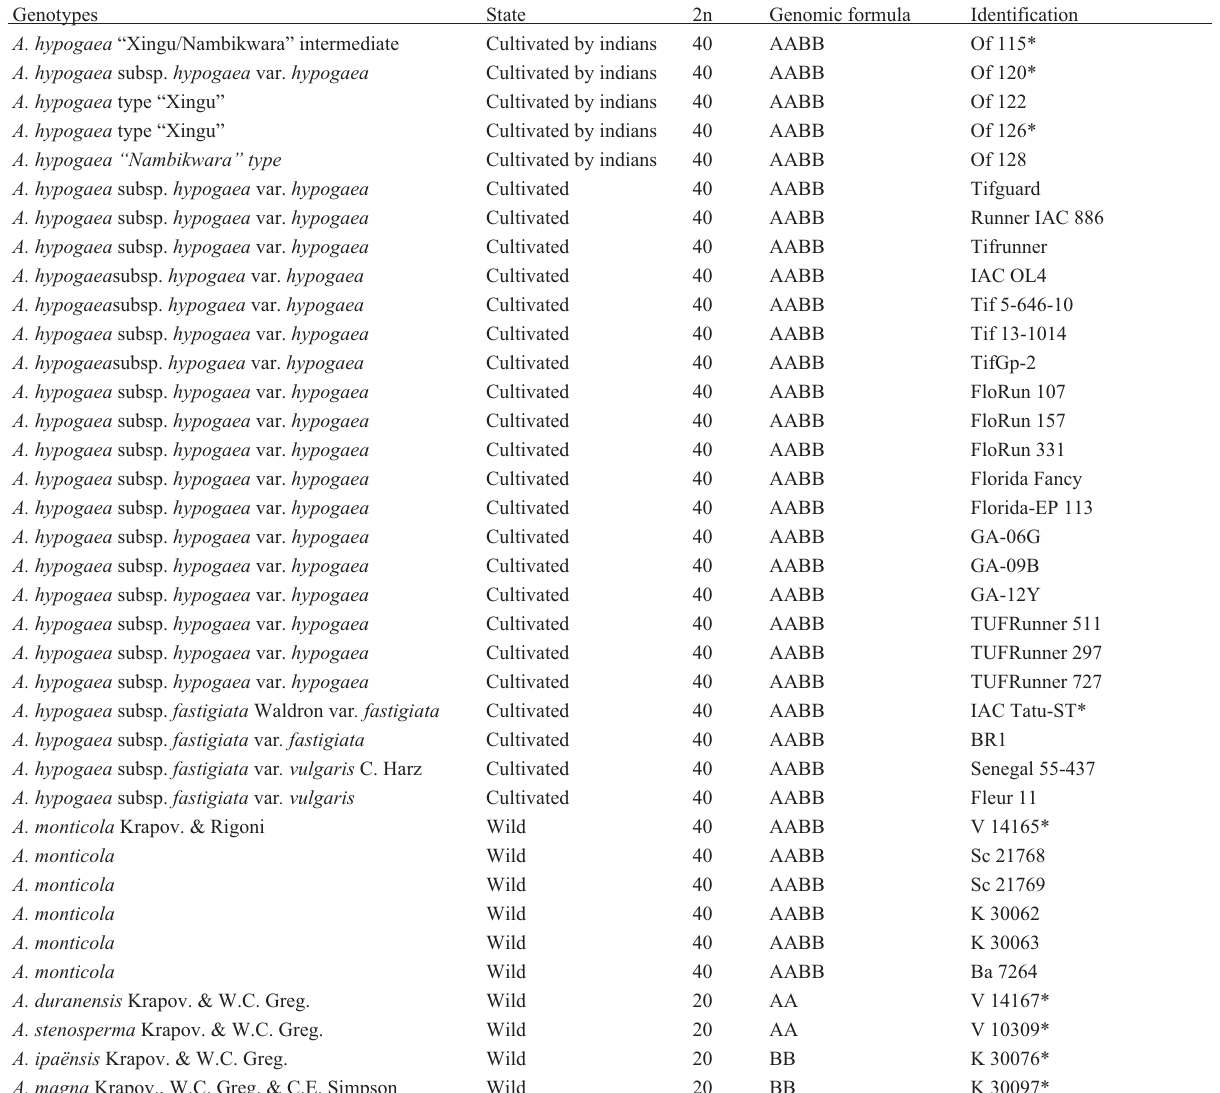
Table 1 - Genotypes of Arachis used for cytogenetic and genotyping analysis, indicating the state, number of chromosomes, genomic formula and identi- fication.